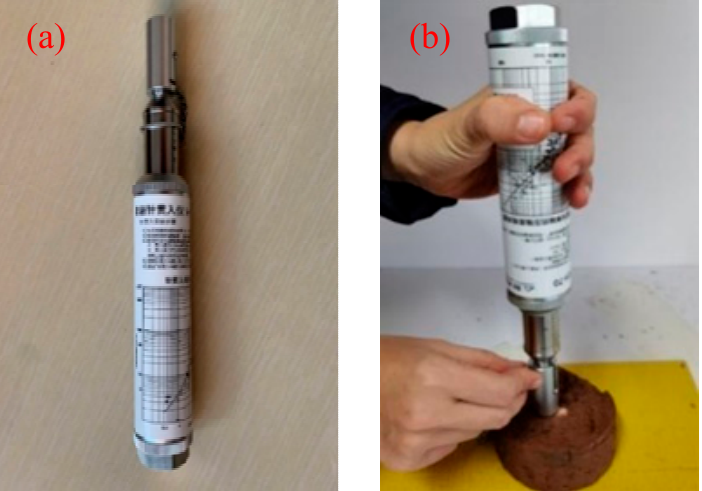
Figure 4. Needle penetrator and test operation chart: ( a ) needle penetrometer; ( b ) Needle penetration test. The strength of mudstone at various points along the cutting edge after simulated piling was measured by a needle penetration instrument, and the test strength value was the average value of multiple points. The section was divided into two cases: within the pile body or at the pile end. Figure 5 reveals the penetration measuring point in the pile body and end sections. The test result of section strength of one test pile is utilized to create a stereo image (Figure 6 is the